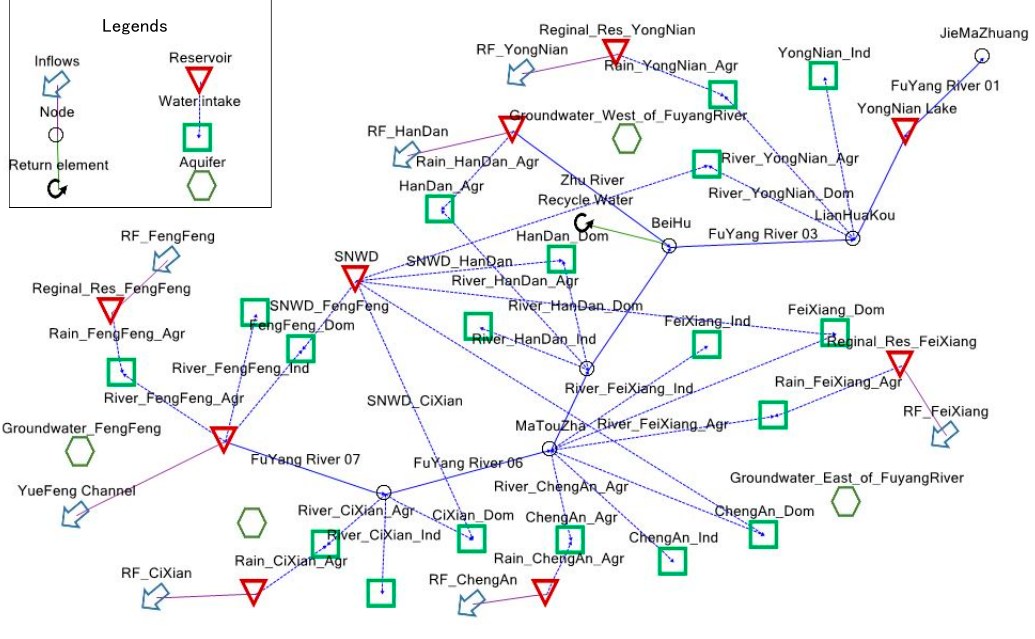
Figure 2. SIMGES model of study area.